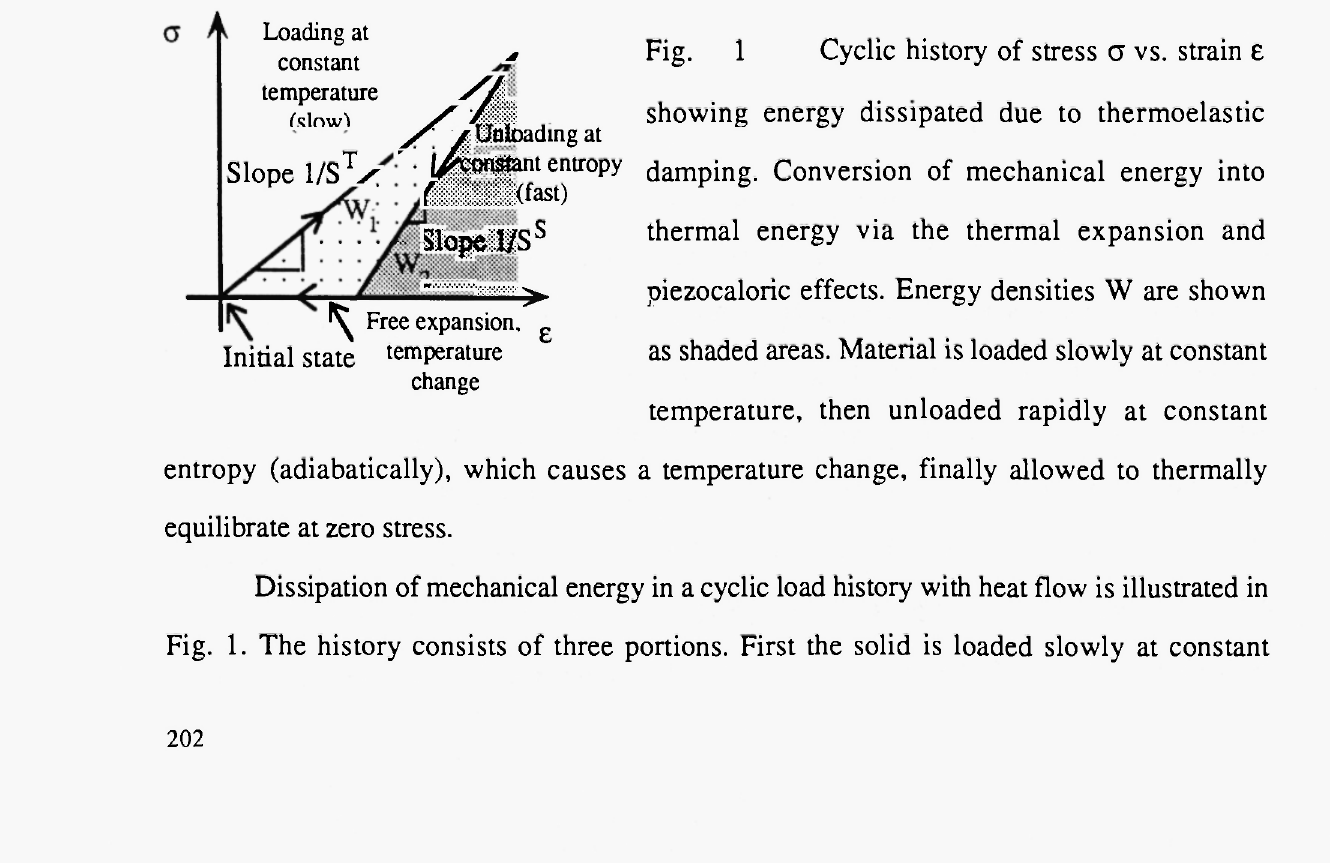
Fig. 1 Cyclic history of stress σ vs. strain ε